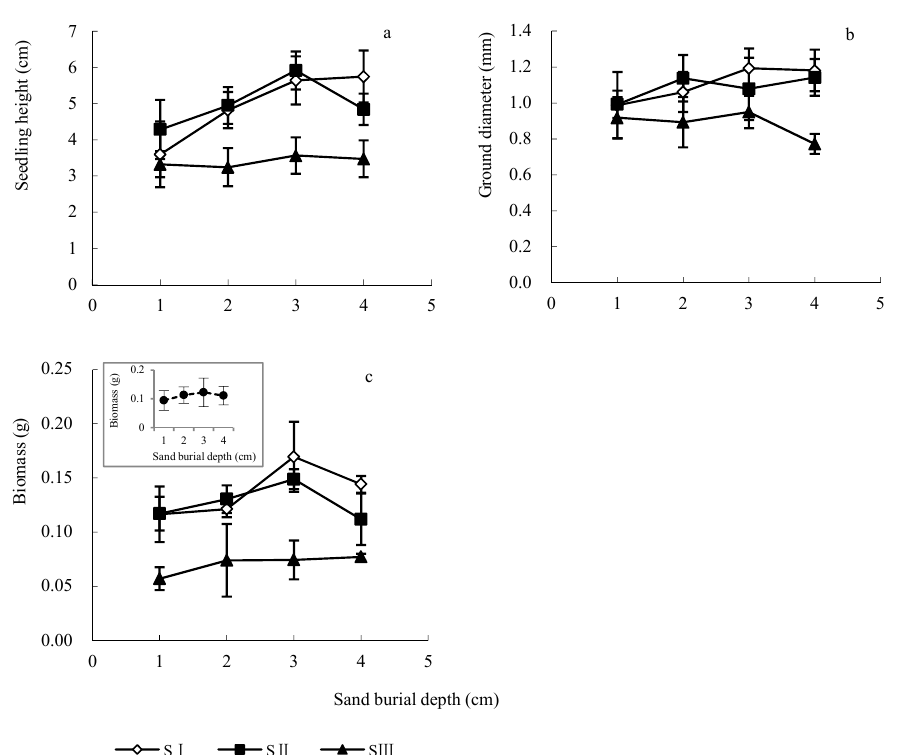
Figure 3. Effects of seed size and sand burial depth on seedling growth. ( a ): seedling height; ( b ): ground diameter; ( c ): biomass. SI: large seeds; SII: medium seeds; SIII: small seeds. Values are means ± standard deviation (SD). Inset panel: variation of mean values of three seed size groups with sand burial depth for biomass. Forests 2019 , 10 , x FOR PEER REVIEW